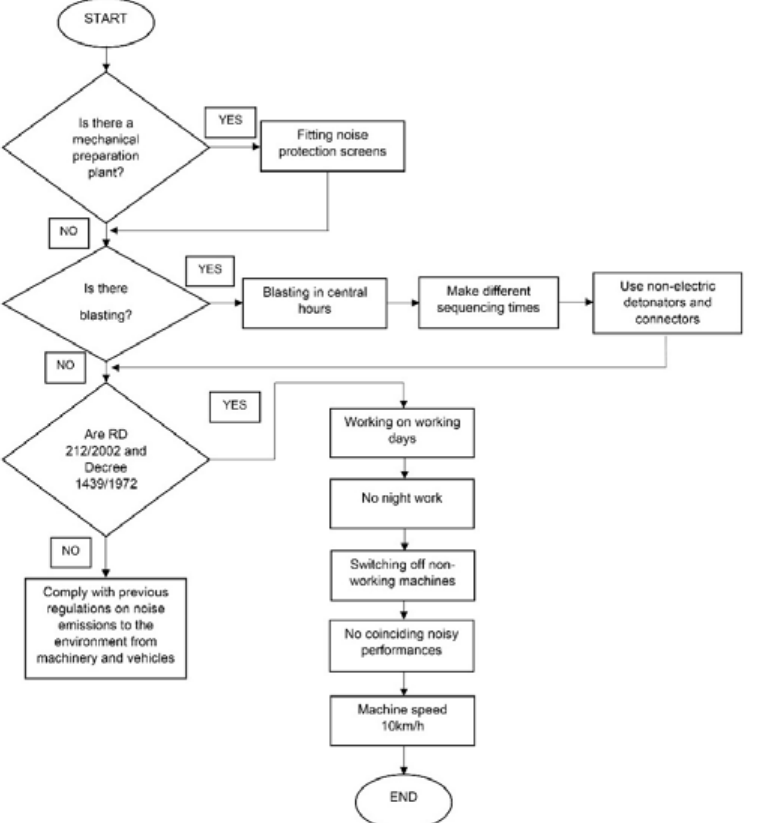
Fig. 3: Flow chart to reduce noise and vibrations in mining